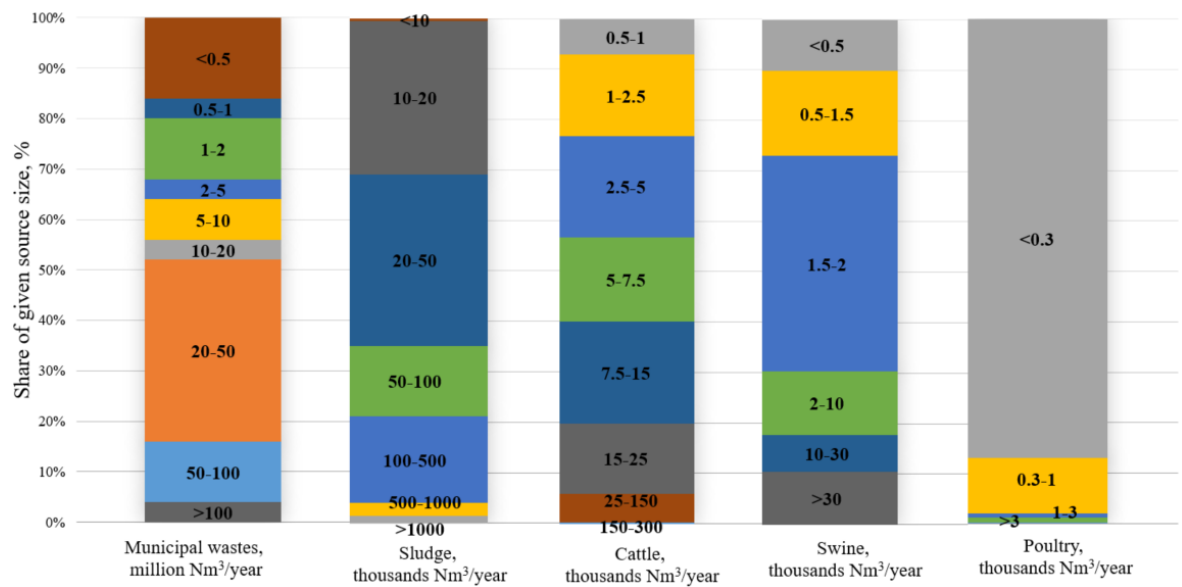
Figure 1. The size distribution of biomethane sources. The labels indicate the range of sizes of the corresponding source in Nm 3 /year. The size of an individual colored block corresponds to the share of given range in